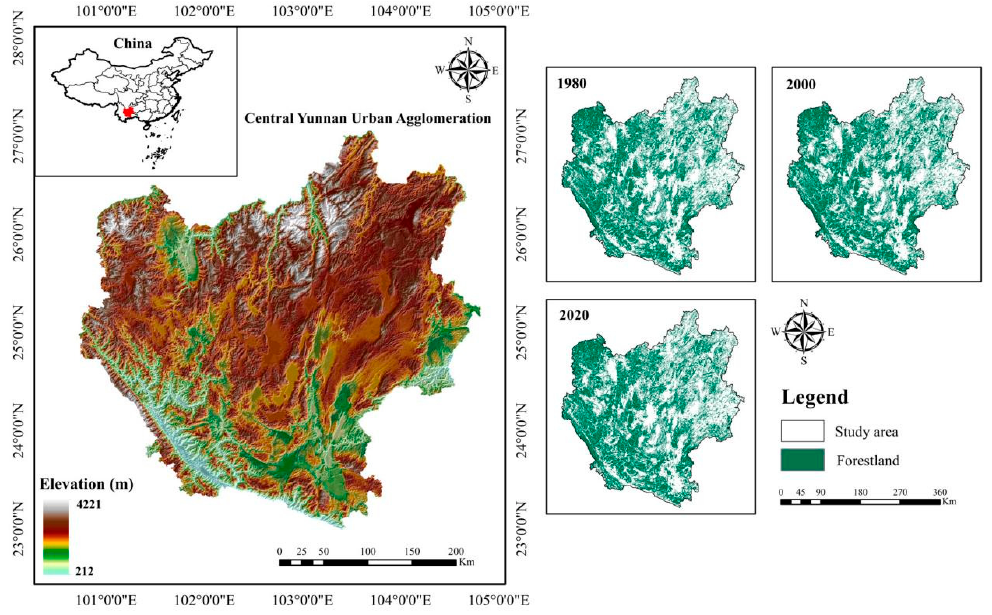
Figure 1. Profile of the Study